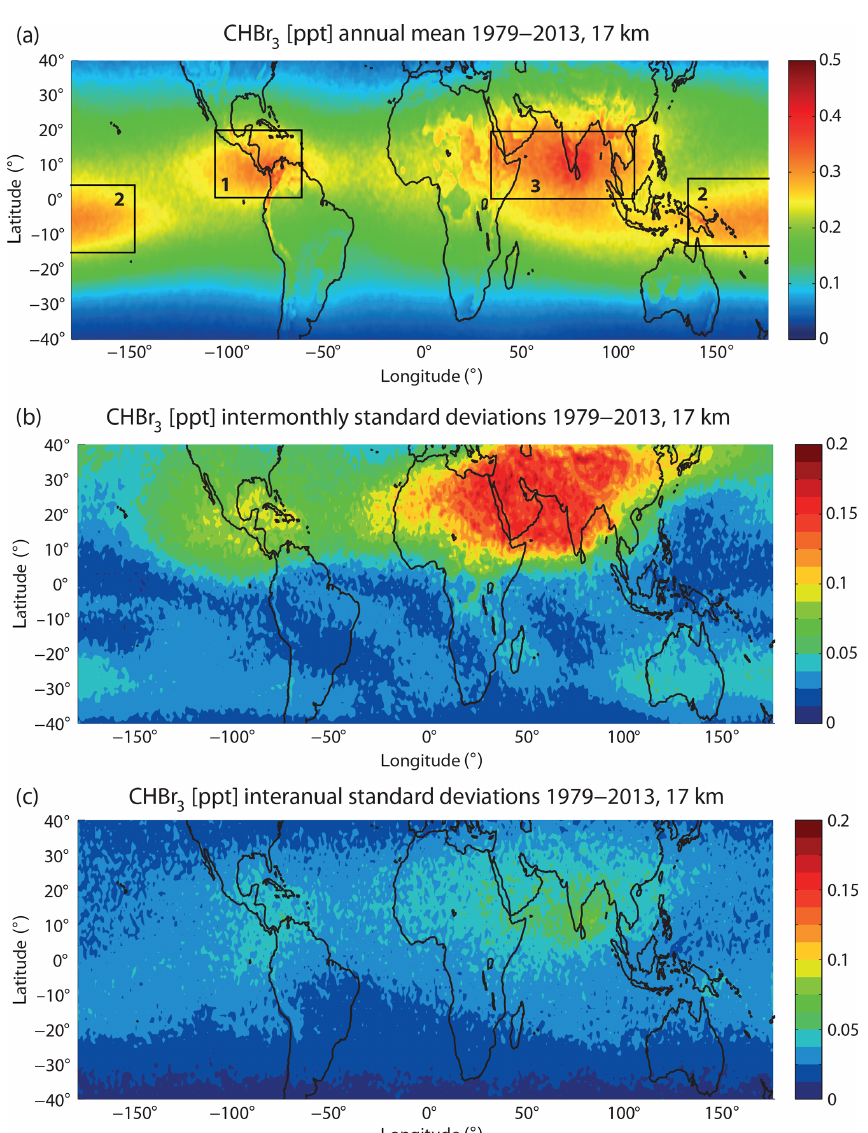
Figure 1. Modelled annual mean distribution of CHBr 3 at 17km for 1979–2013 (a) and the inter-monthly (b) and inter-annual (c) variations given by the standard deviations over all monthly, multi-annual mean, and annual mean values, respectively. Rectangles stand for regions of maximum CHBr 3 mixing ratios and will be discussed in detail in Sect. 3.2 to